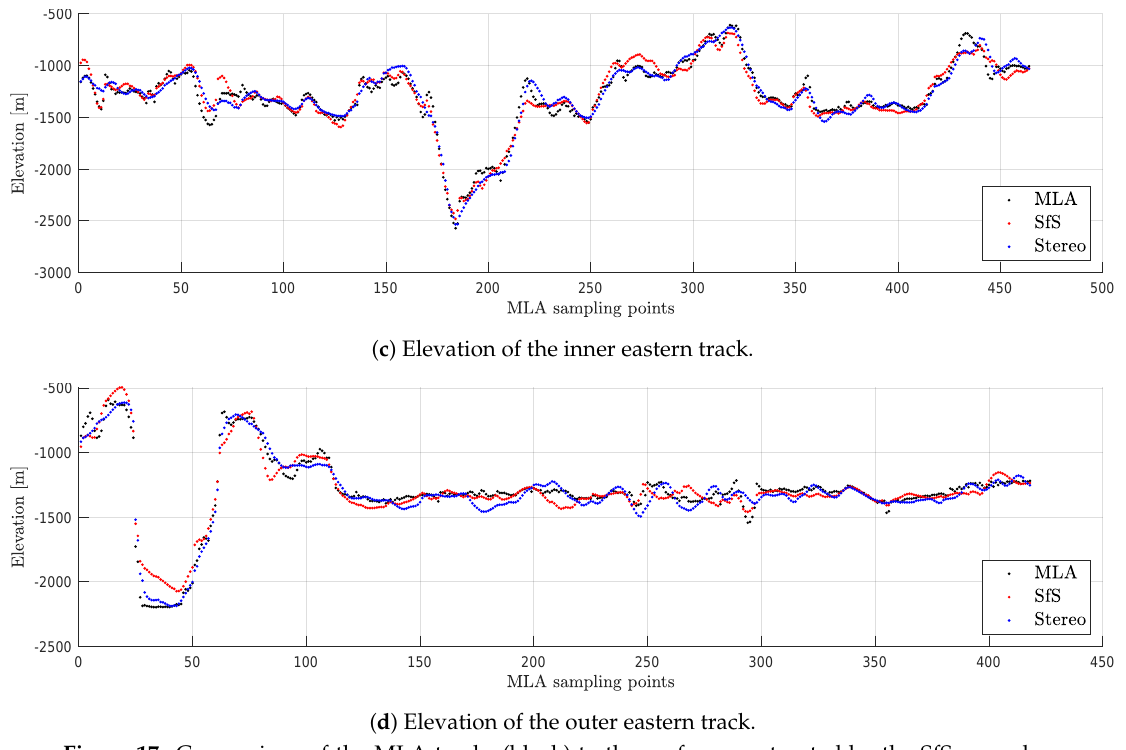
Figure 17. Comparison of the MLA tracks (black) to the surface constructed by the SfS procedure (red) and the initial stereo DTM (blue) of the tectonic fault. The positions of the tracks are given in Figure